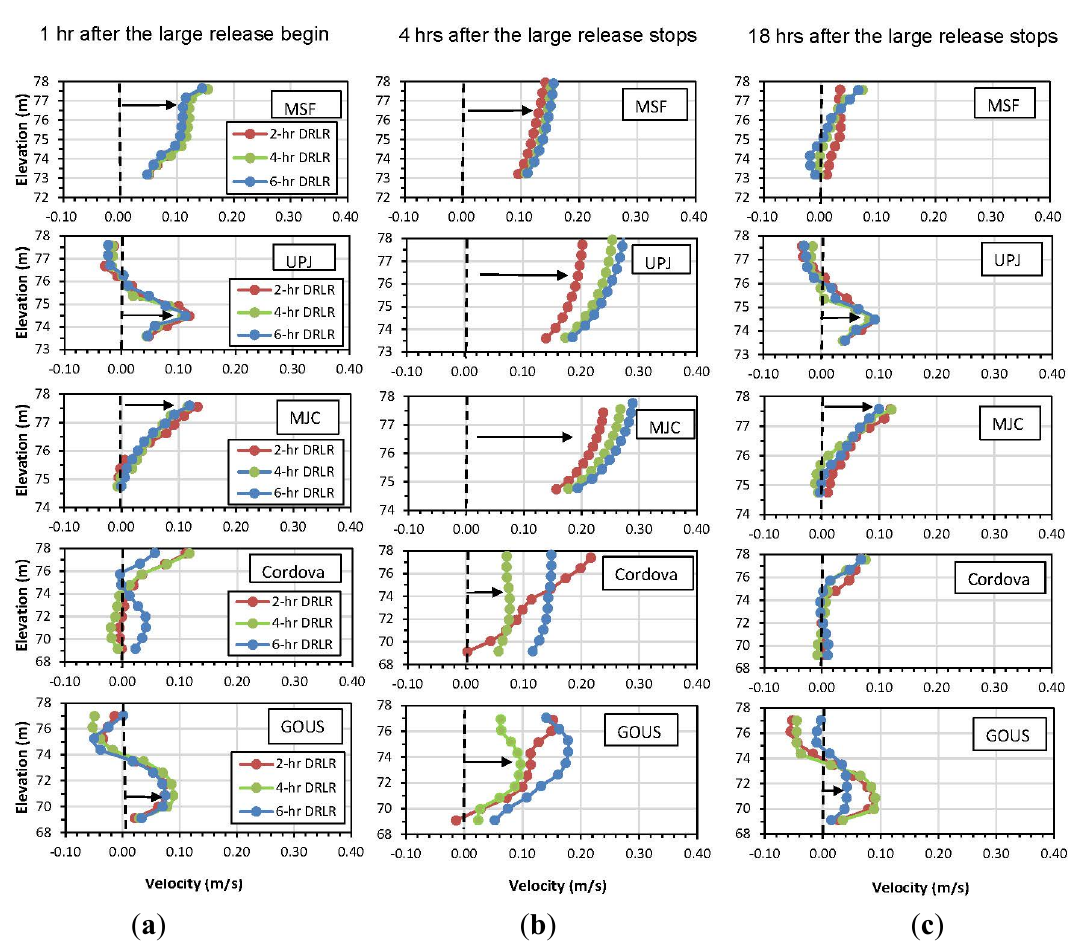
Figure 3. Simulated vertical velocity profiles at the centerlines of MSF, UPJ, MJC,